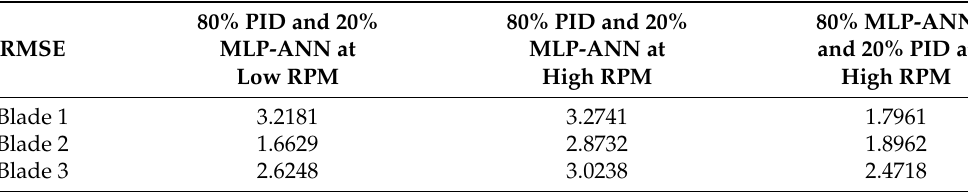
Figure 13. Response of hybrid controller for ( a ) blade 1, ( b ) blade 2 and ( c ) blade 3 at different RPMs. Table 2. RMSE of hybrid controller for different weights.